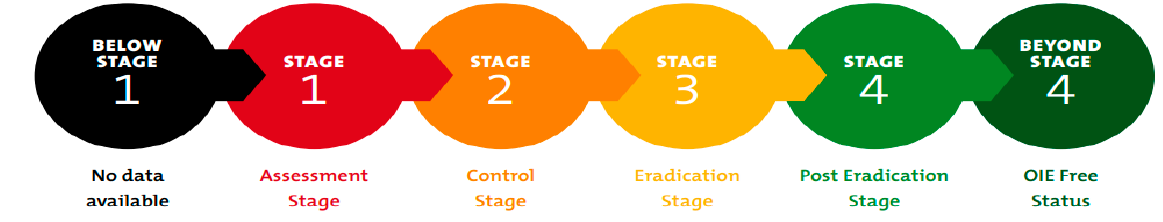
Figure 4. Stages of the global PPR eradication program to declare a country as being PPR-free according to the OIE.